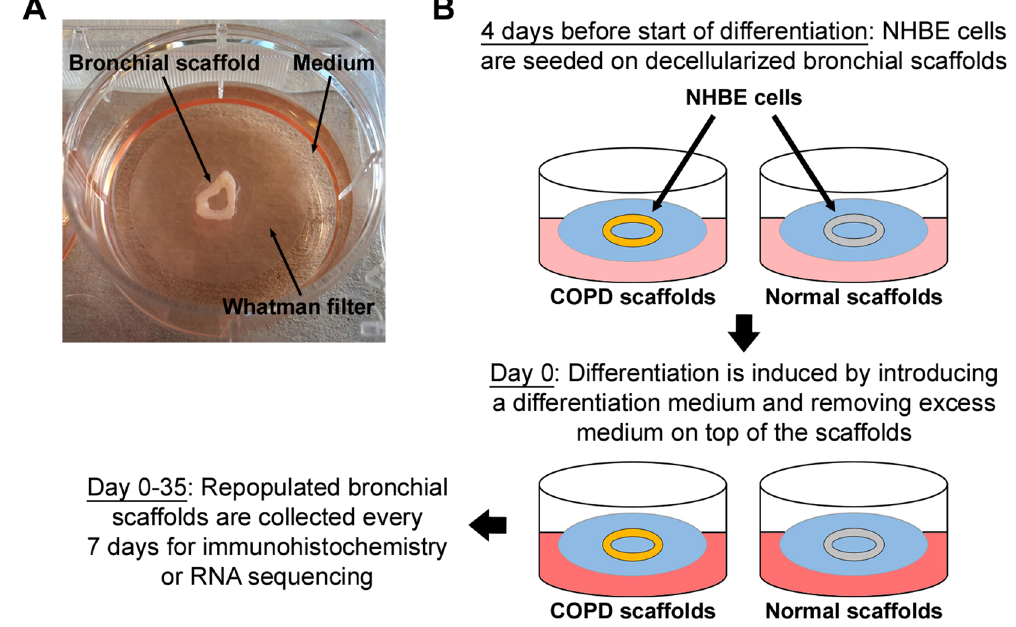
Figure 1. Experimental setup for ex vivo model used for repopulating bronchial scaffolds with primary normal human bronchial epithelial cells. ( A ) After decellularization the bronchial scaffolds are placed on sterile Whatman filters floating on medium in 6-well plates. This setup allows the cells to differentiate close to an air-liquid interface. ( B ) Primary normal human bronchial epithelial (NHBE) cells at passage 3 are seeded on decellularized bronchial scaffolds derived from COPD patients and healthy donors. Four days later the medium used during seeding is replaced with a differentiation medium and excess medium remaining on the scaffolds is removed to maximize exposure to air. Repopulated scaffolds are collected for immunohistochemistry or RNA sequencing on day 0, 7, 14, 21, 28 and 35.